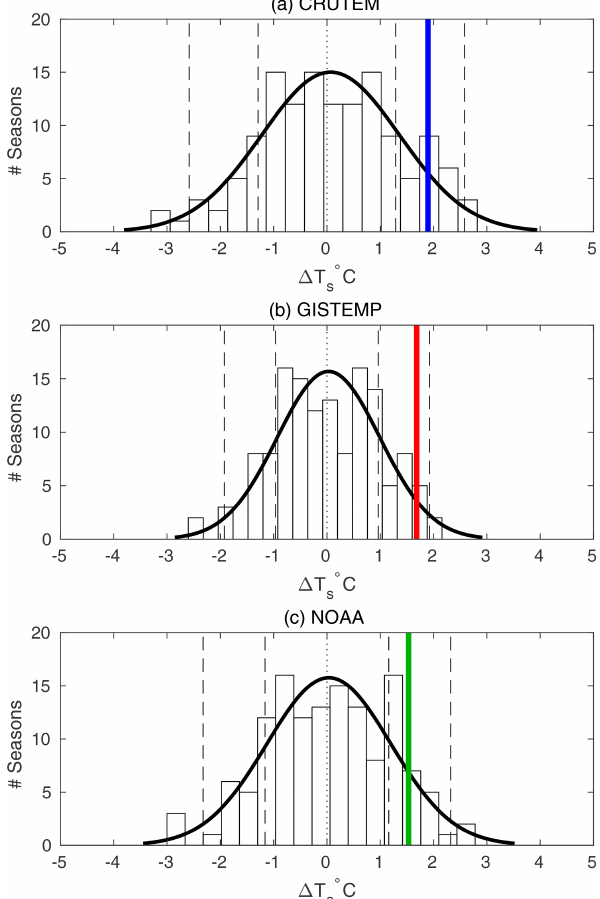
Figure 3. (a) The black boxes show the histogram of the CRUTEM post-Krakatau Eurasian temperature anomalies ( (cid:49)T s ) in DJF, over the period from 1850 to present. The colored bar shows the 1883–84 post-Krakatau anomalies, the solid black lines represent a Gaussian fit, and dashed black lines show the 1 σ and 2 σ intervals. Panels (b) and (c) are the same as panel (a) but for GISTEMP and NOAA, respectively, using the shorter three-winter reference